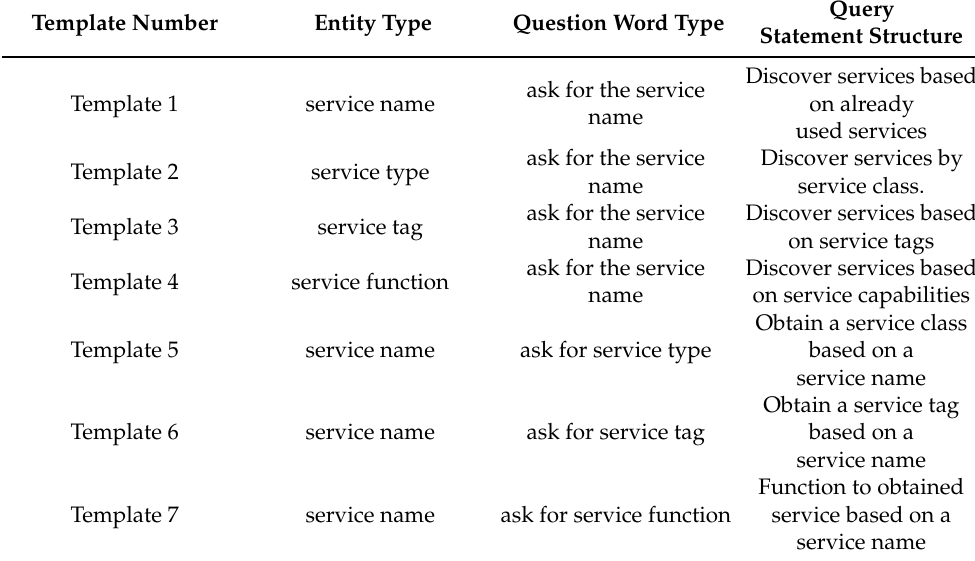
Table 2. Service matching